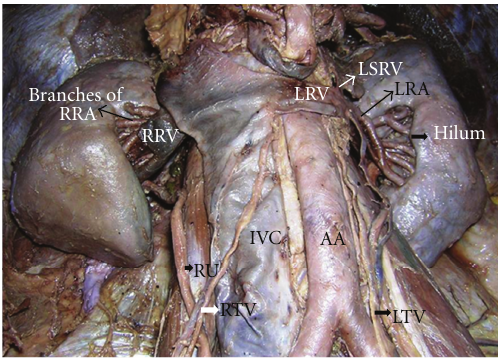
Figure 1: Anomalous vascular branching pattern and their course in the hila of bilateral kidney. IVC: inferior vena cava, AA: abdominal aorta, RU: right ureter, RTV: right testicular vessels, LTV: left testicular vessels, RRV: right renal vein, LRV: left renal vein, and LSRV: left supra renal vein.